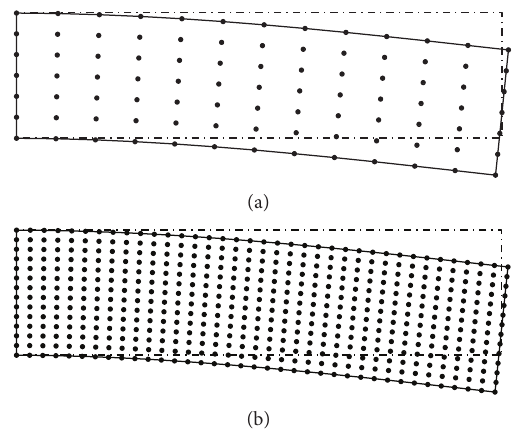
Figure 7: Displacement 13 × 7 (a) and 36 × 13 (b) regular nodes distribution (scaled